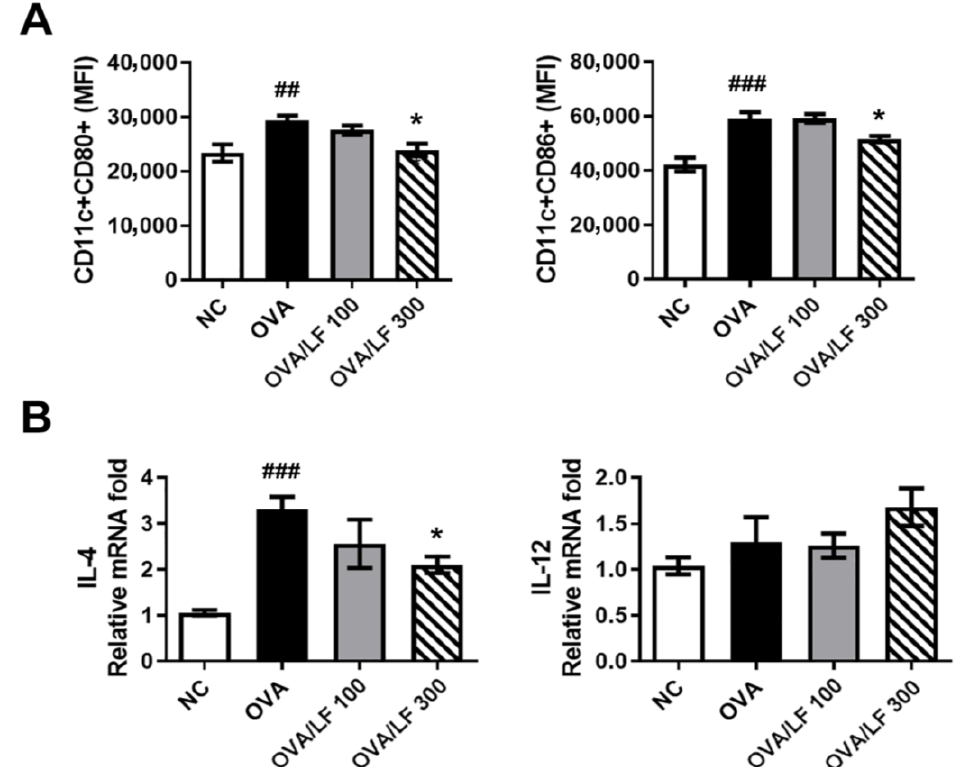
Figure 5. Lactoferrin downregulated the expression of CD80, CD86, IL-4, and IL-12 cytokines in DCs. ( A ) The levels of CD80 and CD86 expression in CD11c+ DC cells were determined by flow cytometry with specific antibodies. ( B ) The levels of IL-4 and IL-12 production in CD11c+ DC cells were detected by qRT-PCR. The data are expressed as the mean ± S.E.M. values ( n = 5). ## p < 0.01, ### p < 0.001 vs. the NC group; * p < 0.05 vs. the OVA group. NC: Normal control; OVA: ovalbumin; OVA/LF 100: OVA + lactoferrin 100 mg/kg; OVA/LF 300: OVA + lactoferrin 300 mg/kg.